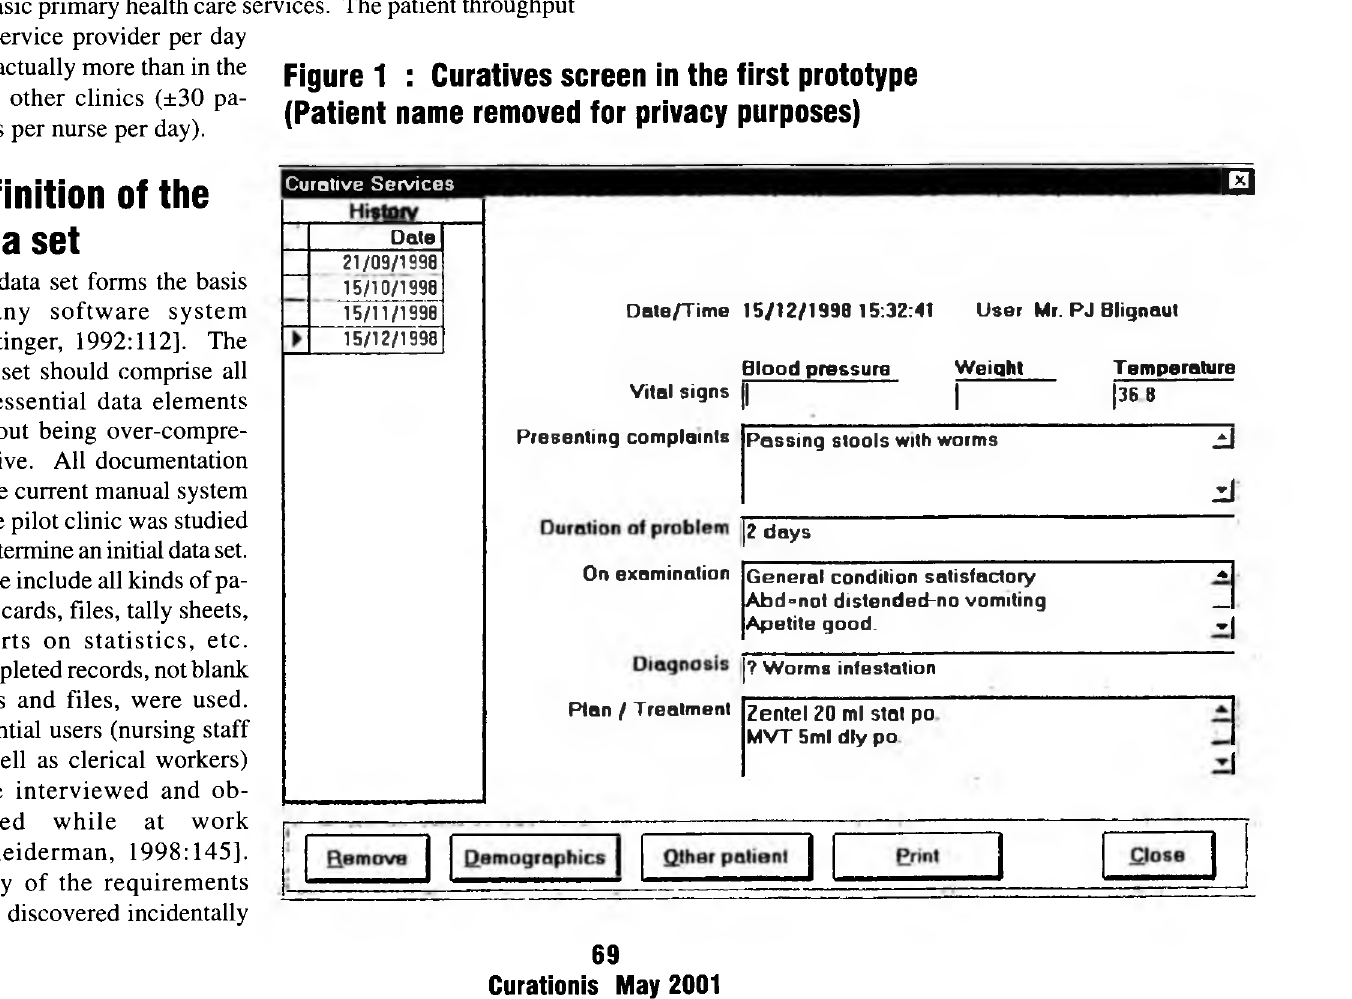
Figure 1 : Curatives screen in the first prototype (Patient name removed for privacy